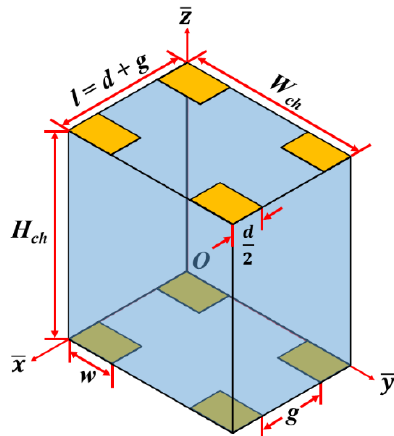
Figure 4. Schematic of the repeating unit for both focusing and separation sections ( H ch : microchannel height, W ch : microchannel width, l : repeating unit length, w : electrode length, d : electrode width, g : gap between electrodes, and O : origin).